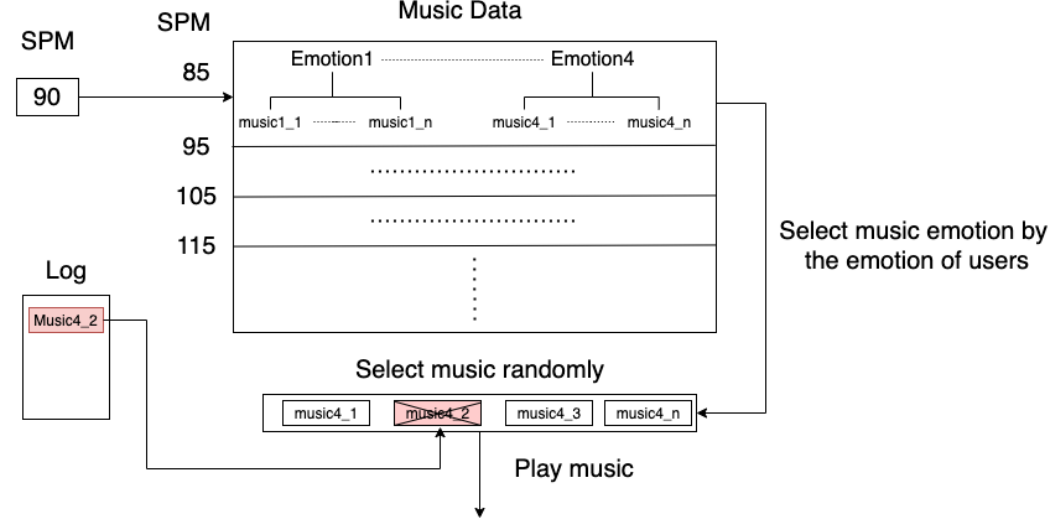
Figure 4. A description of the music selection